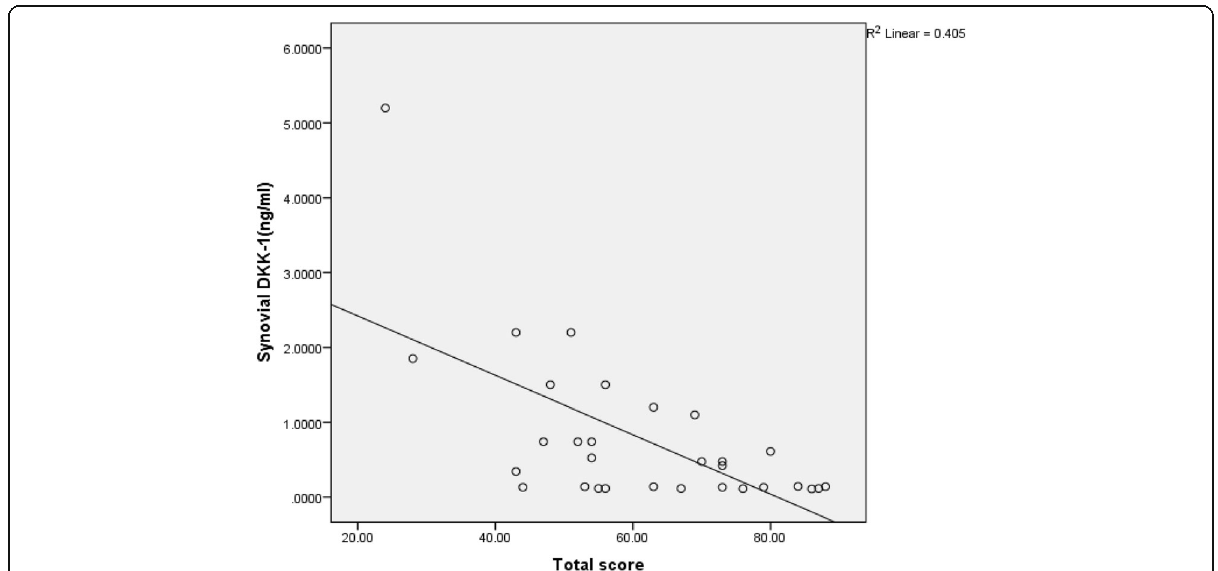
Fig. 1 Correlation between synovial Dkk-1 levels and total WOMAC index score in primary knee OA